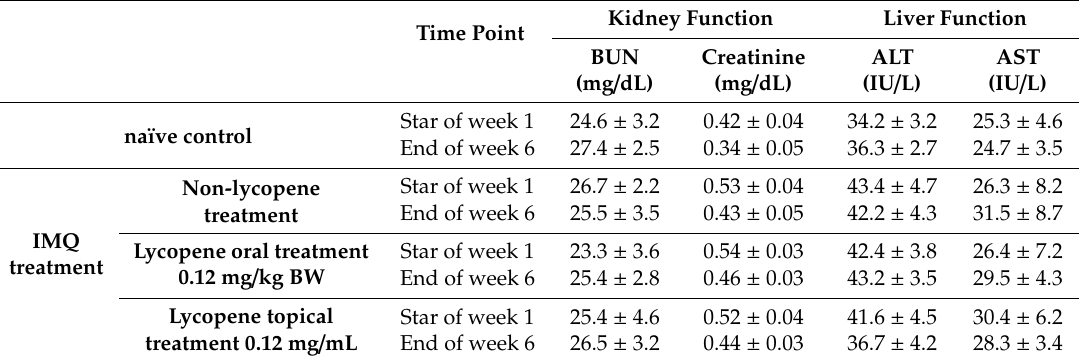
Table 1. Plasma biochemical characteristics in experimental mice ( n = 5).